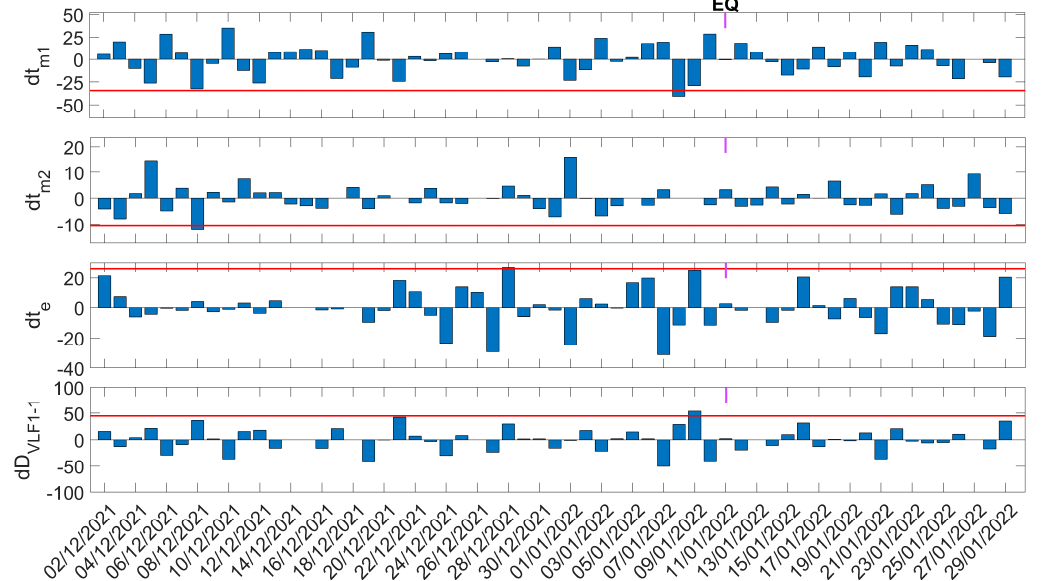
Figure 6. Temporal evolution of the shifts in the morning and evening TTs, as well as of the “VLF daylength” for the propagation path GERSR during the studied period (2 December 2021 to 29 January 2022). Red solid horizontal lines indicate the corresponding +2 𝜎 / − 2 𝜎 limits; 𝜎 is calculated for the whole studied period for each panel. EQ date is marked at the top of each panel.